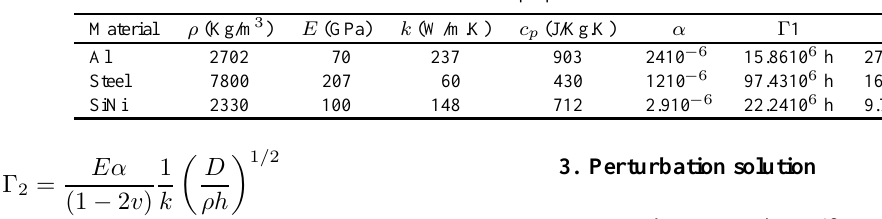
Table 1 Thermal and mechanical properties of used